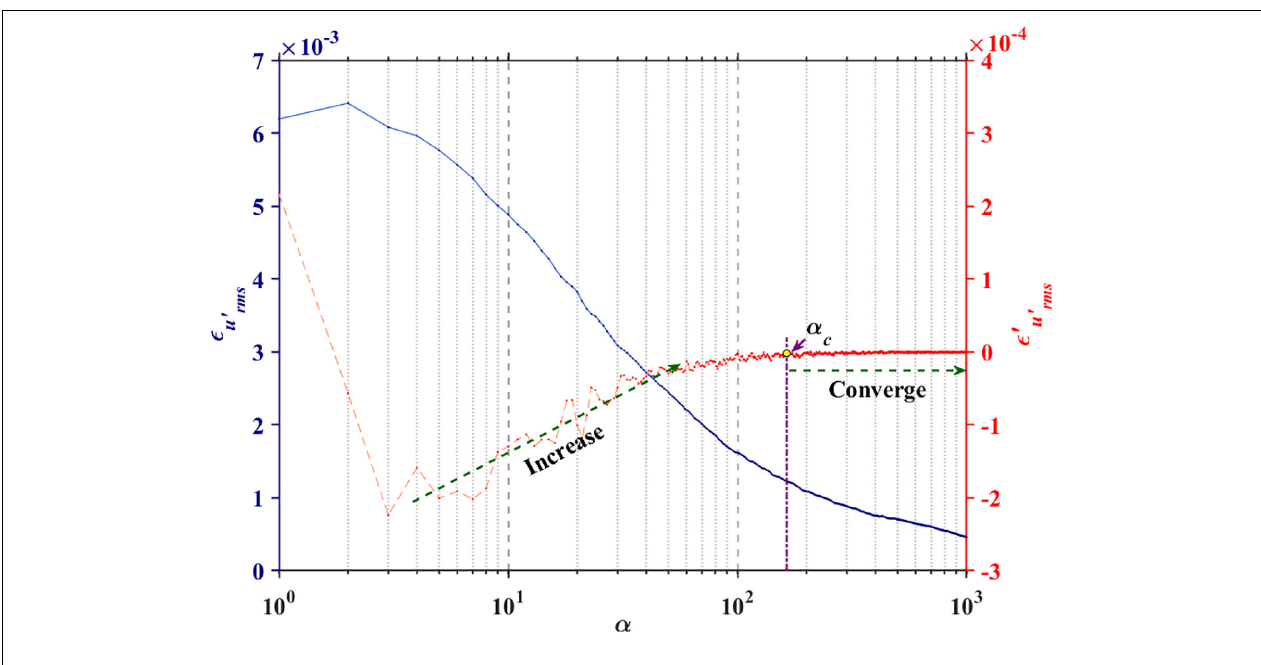
with the sample length, α and ε (cid:48) u (cid:48) rms rms